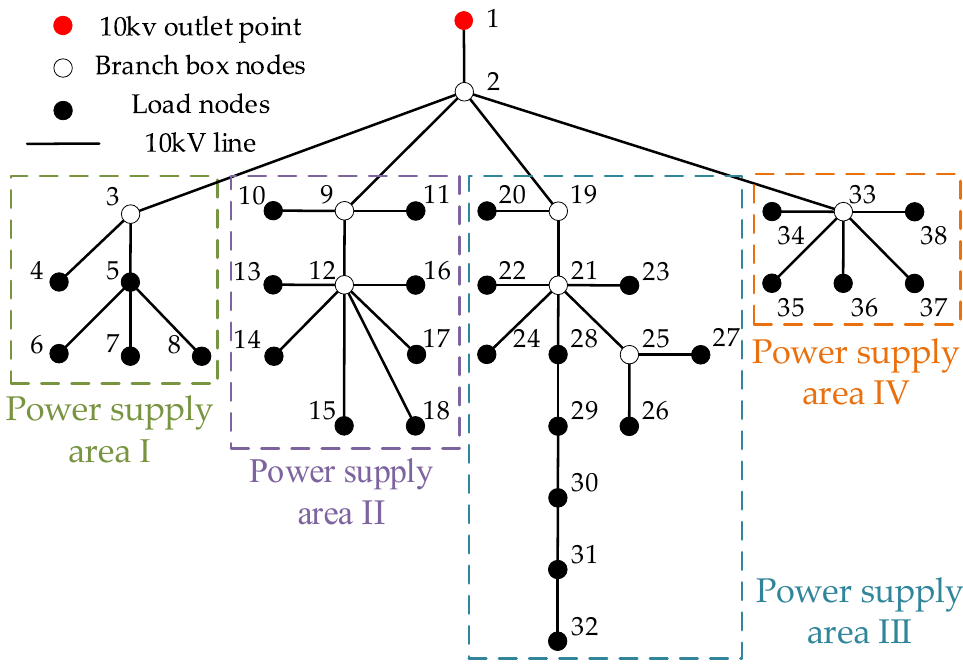
Figure 6. Distribution network area division.